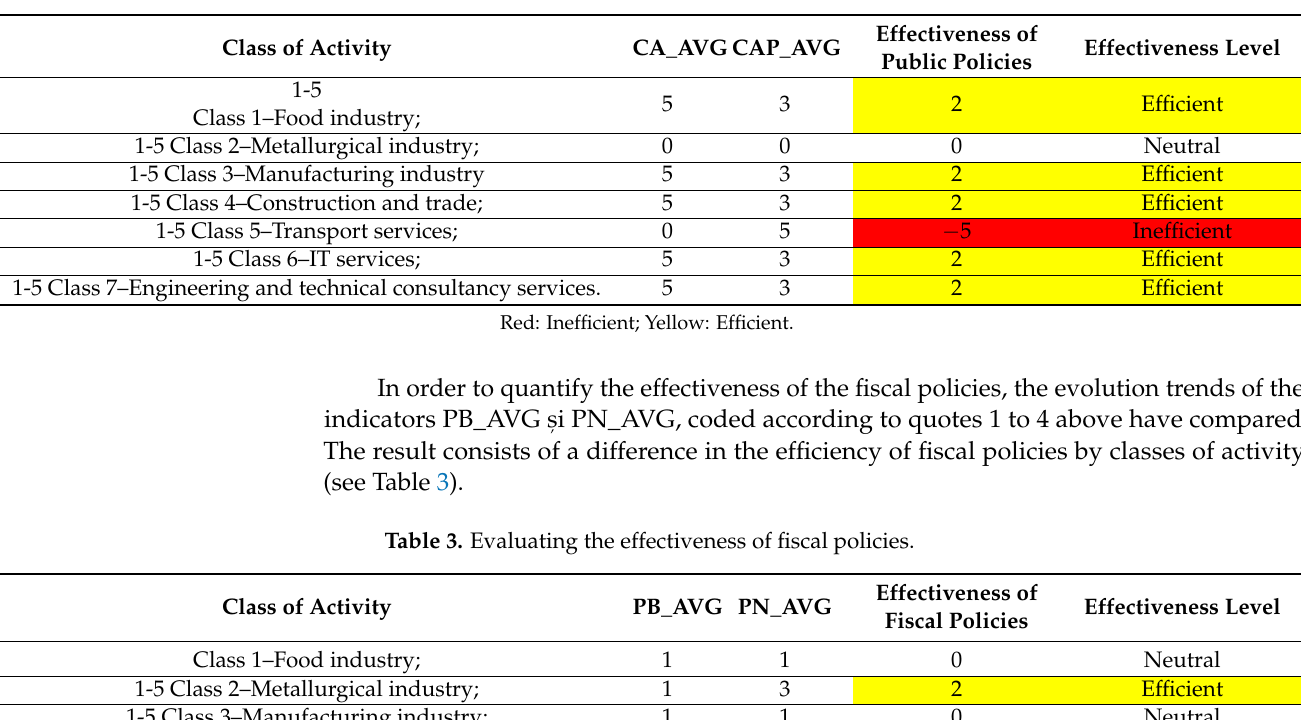
Table 2. Evaluating the effectiveness of public policies.